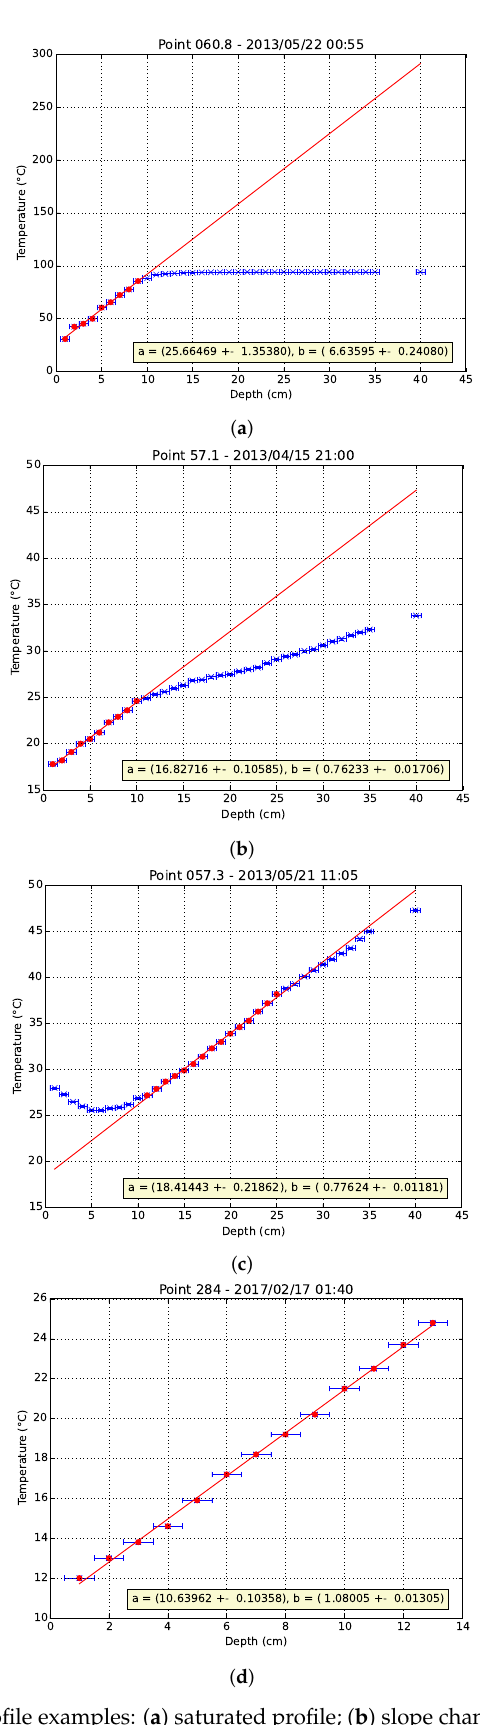
Figure 3. Temperature profile examples: ( a ) saturated profile; ( b ) slope changing gradient; ( c ) inverted gradient; and ( d ) fully linear. Points of type: ( a , b , d ) are the red and blue ones of Figure 2; and ( c ) are the black ones in the same figure. The yellow box of each sub-figure is the result of the linear fit performed on the red points in the form T = a + bz being T the measured temperature and z the